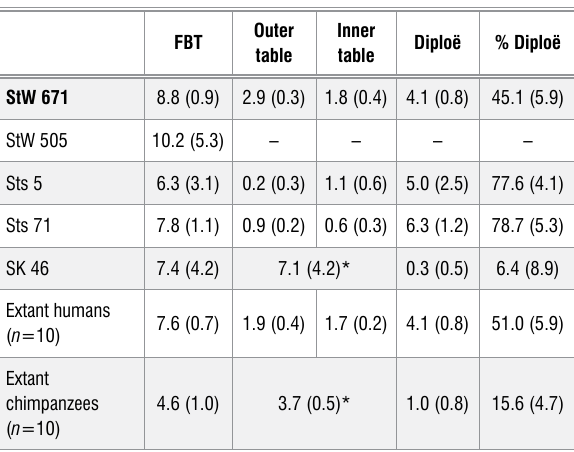
Mean frontal bone thickness (FBT, mm) and relative proportions of the diploë (%) of StW 671 compared to the estimates from some Plio-Pleistocene hominin specimens and extant humans and chimpanzees. Standard deviations are shown in brackets.